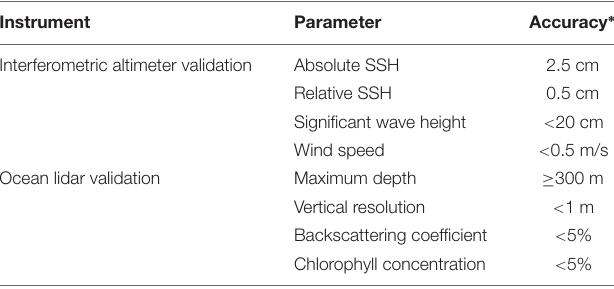
TABLE 4 | Parameter and accuracy for the Guanlan IA/OL in situ validation system.